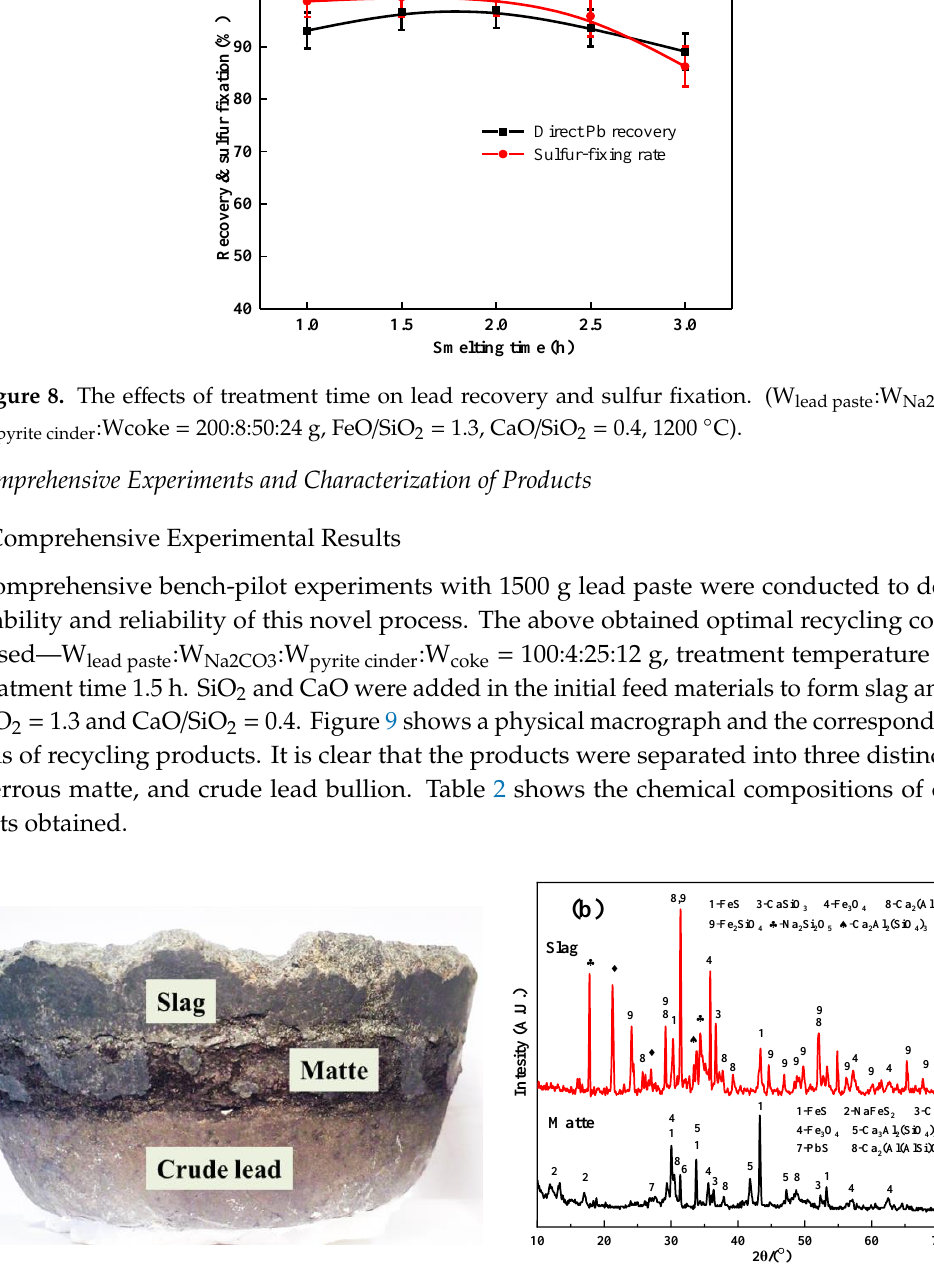
Figure 9. Physical macrograph ( a ) and corresponding XRD patterns ( b ) of the recycling products. (W lead paste :W Na2CO3 :W pyrite cider :W coke = 1500:60:375:180 g, FeO/SiO 2 = 1.3, CaO/SiO 2 = 0.4, 1200 °C, 1.5 h). Table 2. Chemical compositions of recycling products in the comprehensive expansion experiments (wt.%), * g/t.